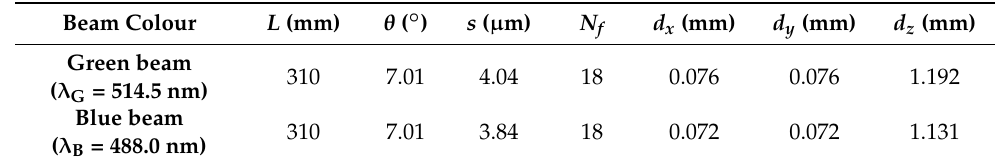
Table 1. Optical parameters of LDA